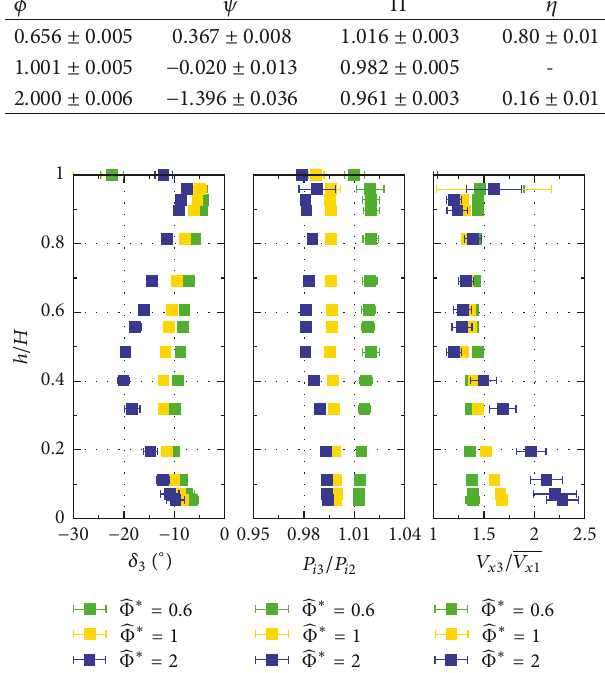
Figure 3: 95% confidence intervals for local measurements at rotor outlet in compressor mode, freewindmill, and load-controlled windmill.